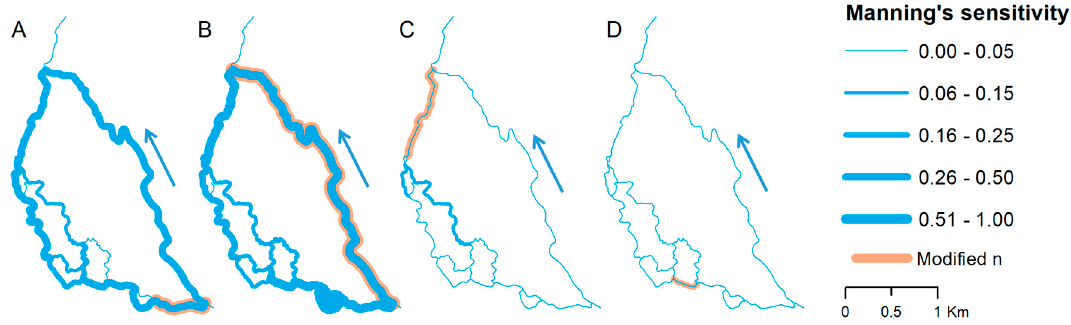
Figure 6. Flow distribution changes as a response to Manning’s n alteration in: ( A ) Reach 2; ( B ) Reach 19; ( C ) Reach 21; and ( D ) Reach 6, representing summer conditions. Blue arrow indicates direction of flow. Reach numbering according to Figure 4.